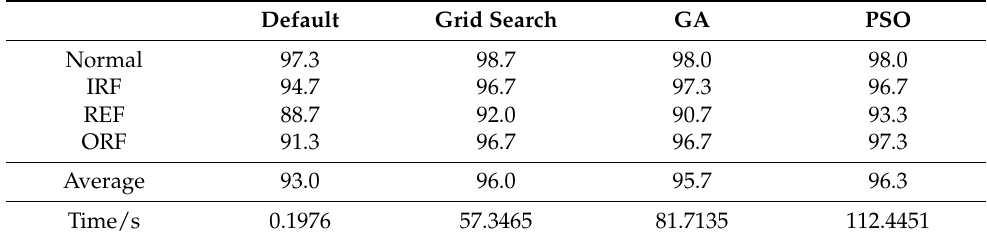
Table 2. The classification result with different parameters